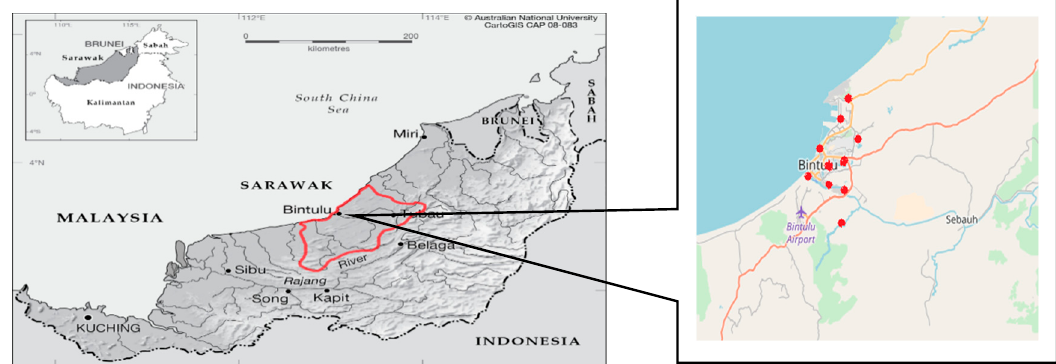
Figure 2. Location of study area: Bintulu Division, Sarawak, West Malaysia Borneo (shown in red dots).